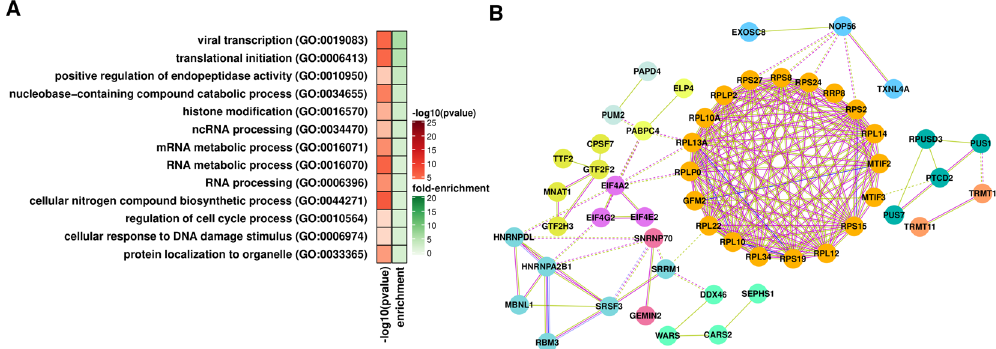
Figure 4. Impact of radiation on the splicing profile of glioblastoma cells. ( A ) GO-enriched terms among genes showing changes in splicing profiles at T24. GO-enriched terms are summarized using REVIGO 97 . ( B ) Protein- protein interaction networks according to STRING 98 showing genes associated with RNA-related functions whose splicing profiles displayed alterations at T24. Gene clusters based on the strength of connection and gene function are identified by color. Lines color indicate type of association: light green, an association based on literature findings; blue indicates gene co-occurrence; magenta indicates experimental evidence.